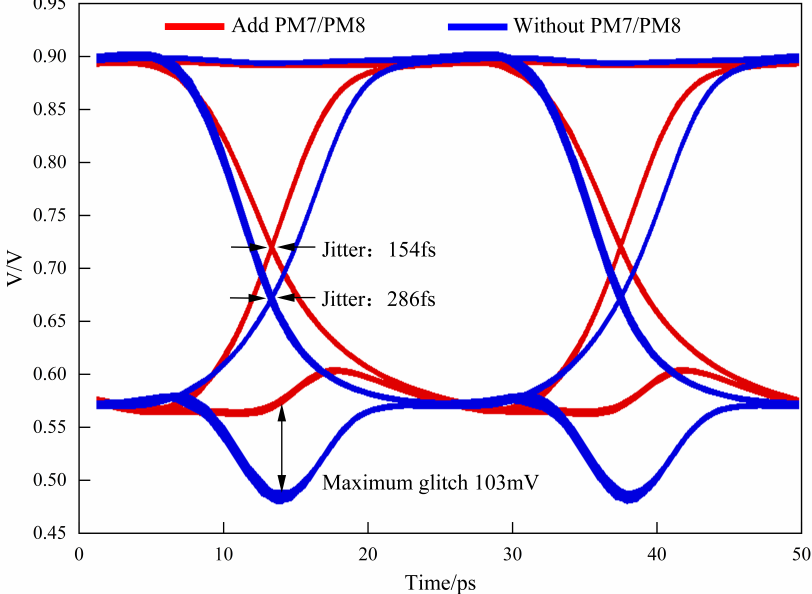
Figure 10. Simulation comparison of the output eye diagram of 4:1 MUX with and without